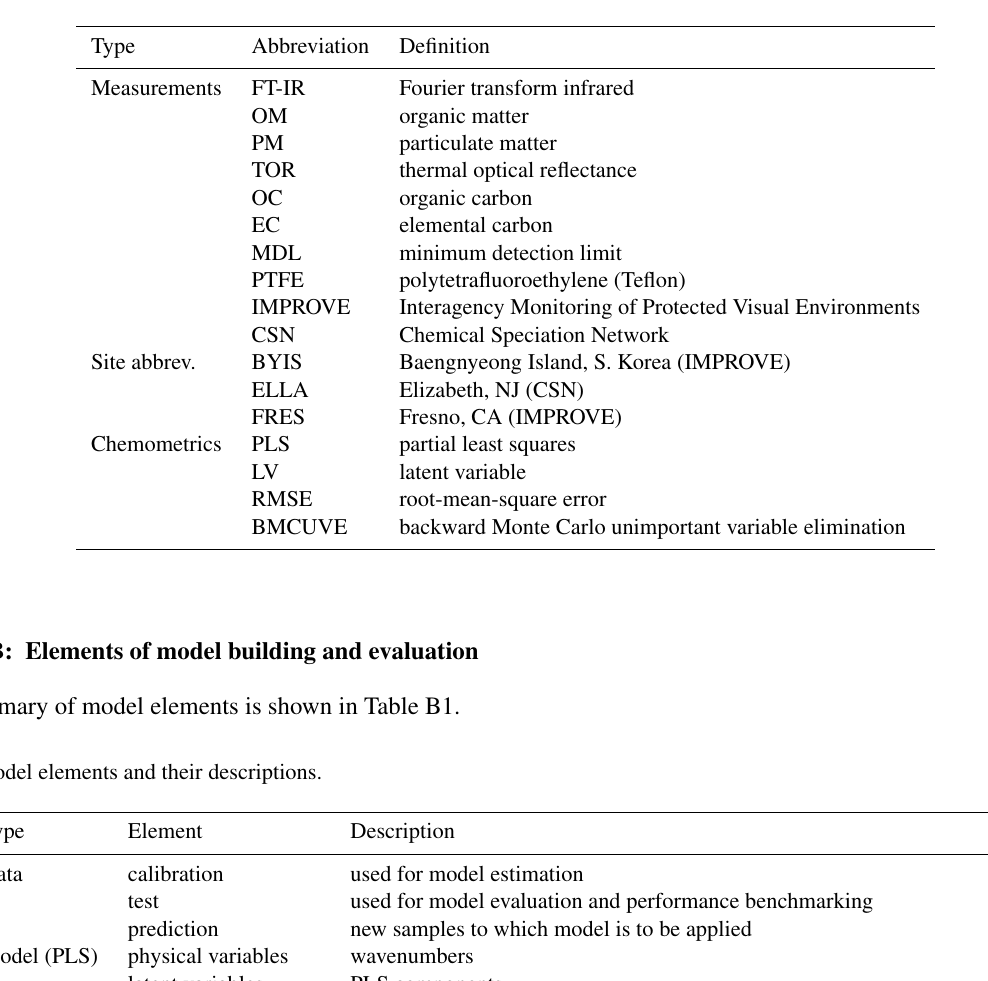
Table A1. List of abbreviations and their definitions.